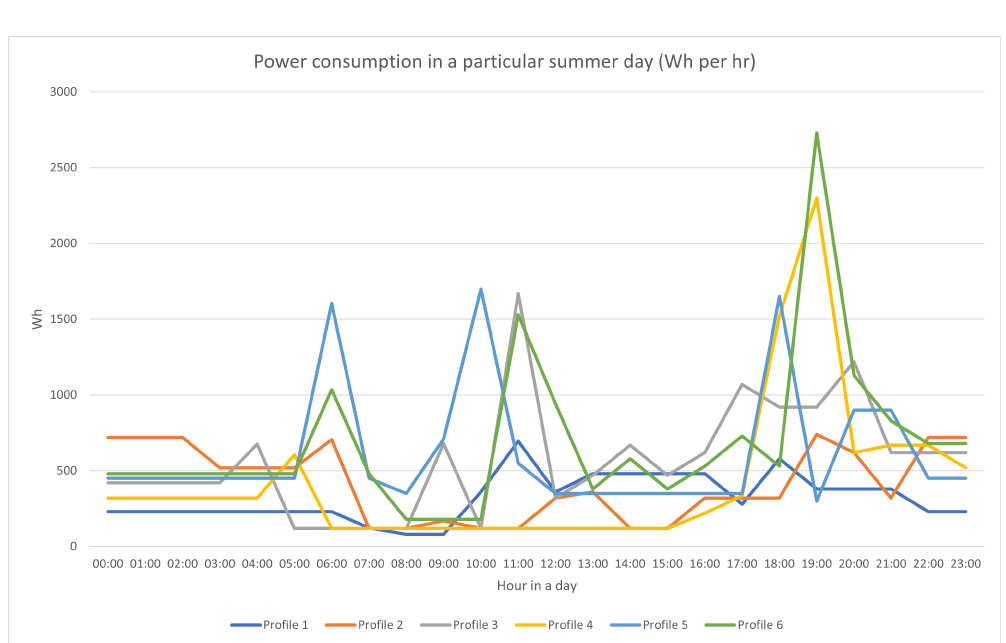
Figure 4. Visual representation of all the load